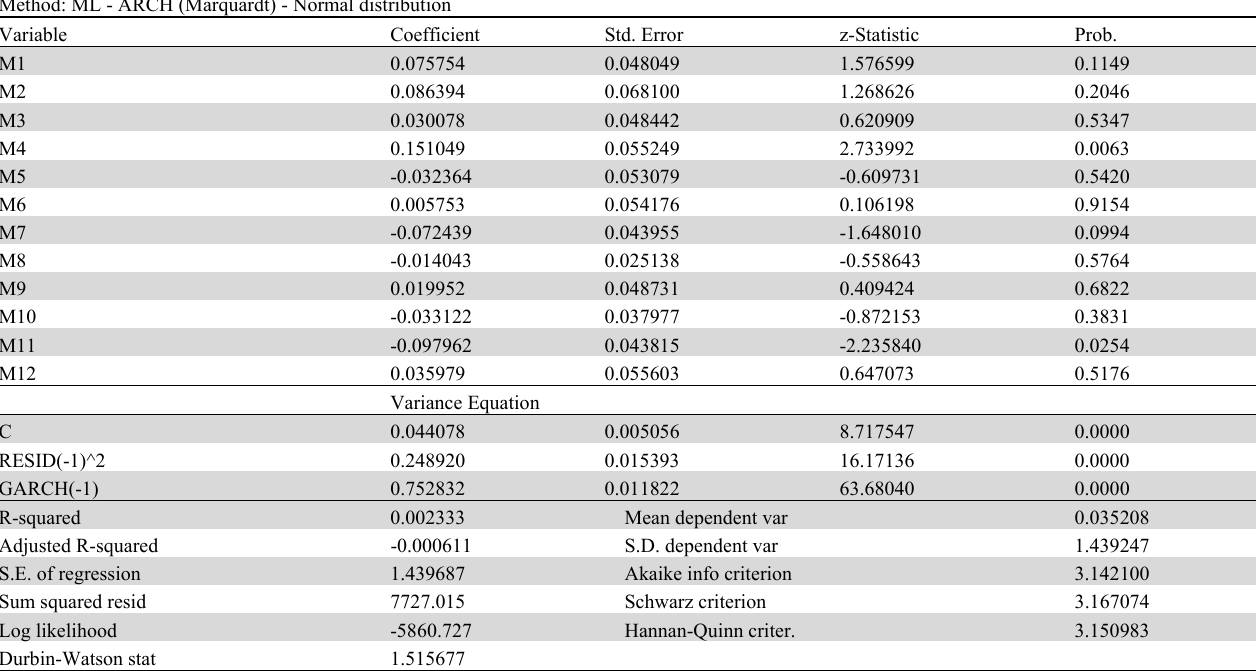
Results of the GARCH model